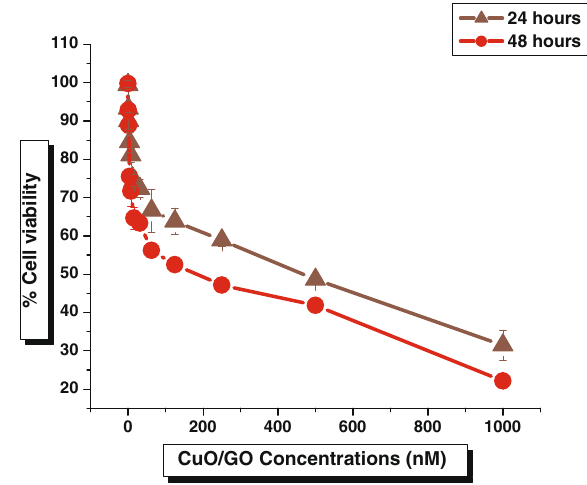
Fig. 8 Cell viability of A-431 after treatment with different CuO/GO nanocomposites concentrations after 24 and 48 h. Error bar represents the standard deviation of the mean * p ≤